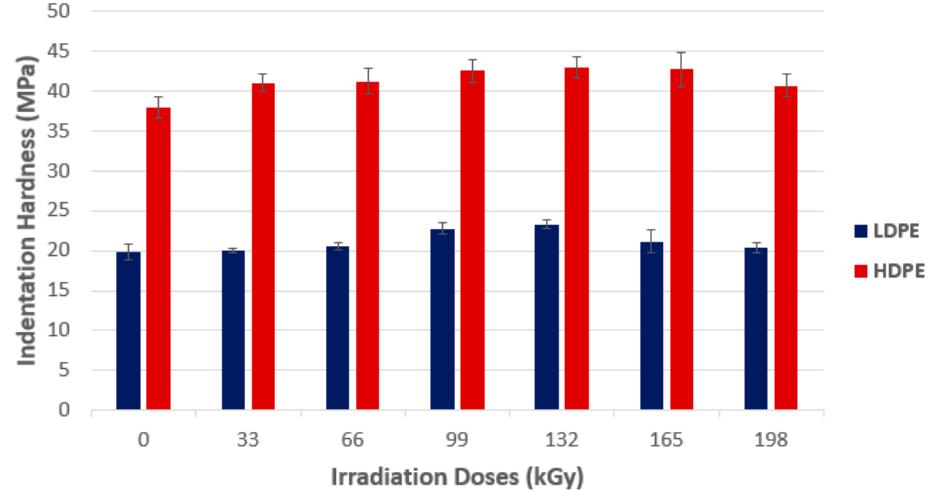
Figure 3. Indentation hardness ( H IT )—Commodity polymers.